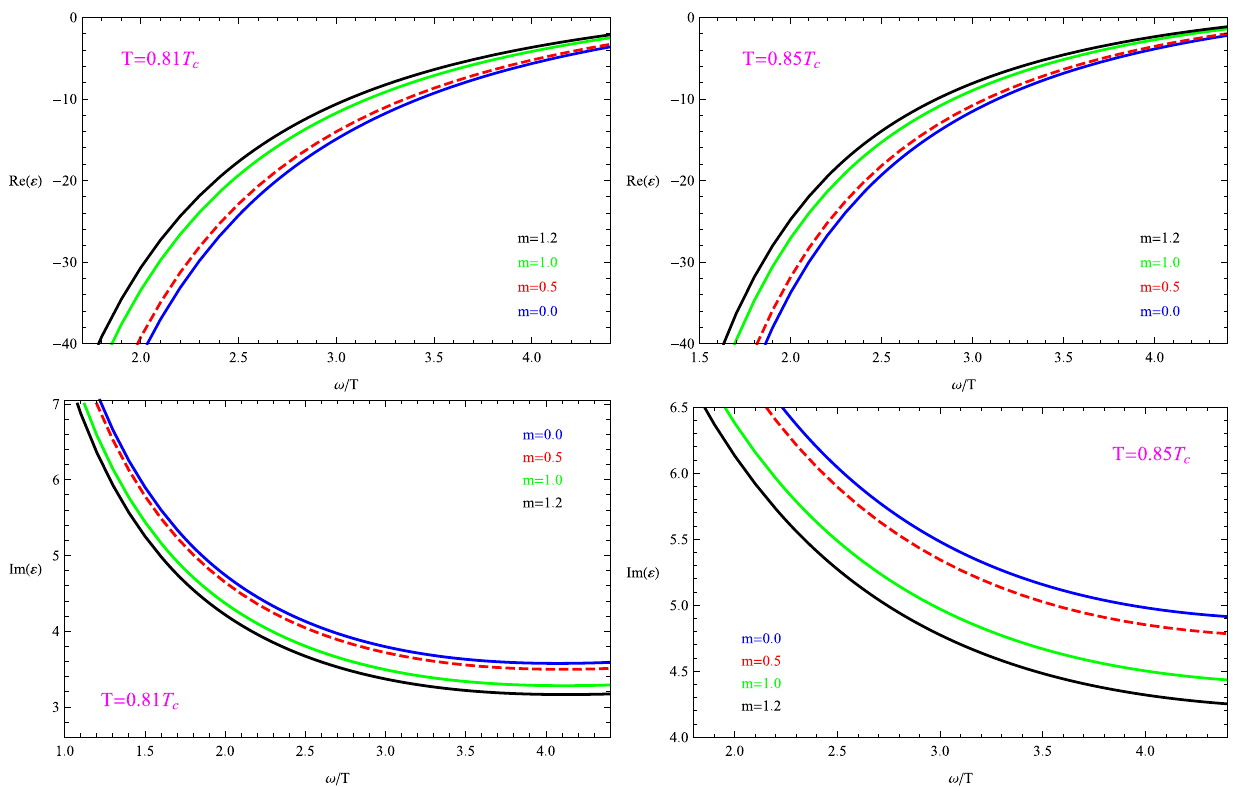
Fig. 3 Real (top) and imaginary (bottom) parts of the permittivity (cid:17) as a function of ω/ T with the fixed temperatures T = 0 . 81 T c (left) and T = 0 . 85 T c (right) for different values of the graviton mass parame-